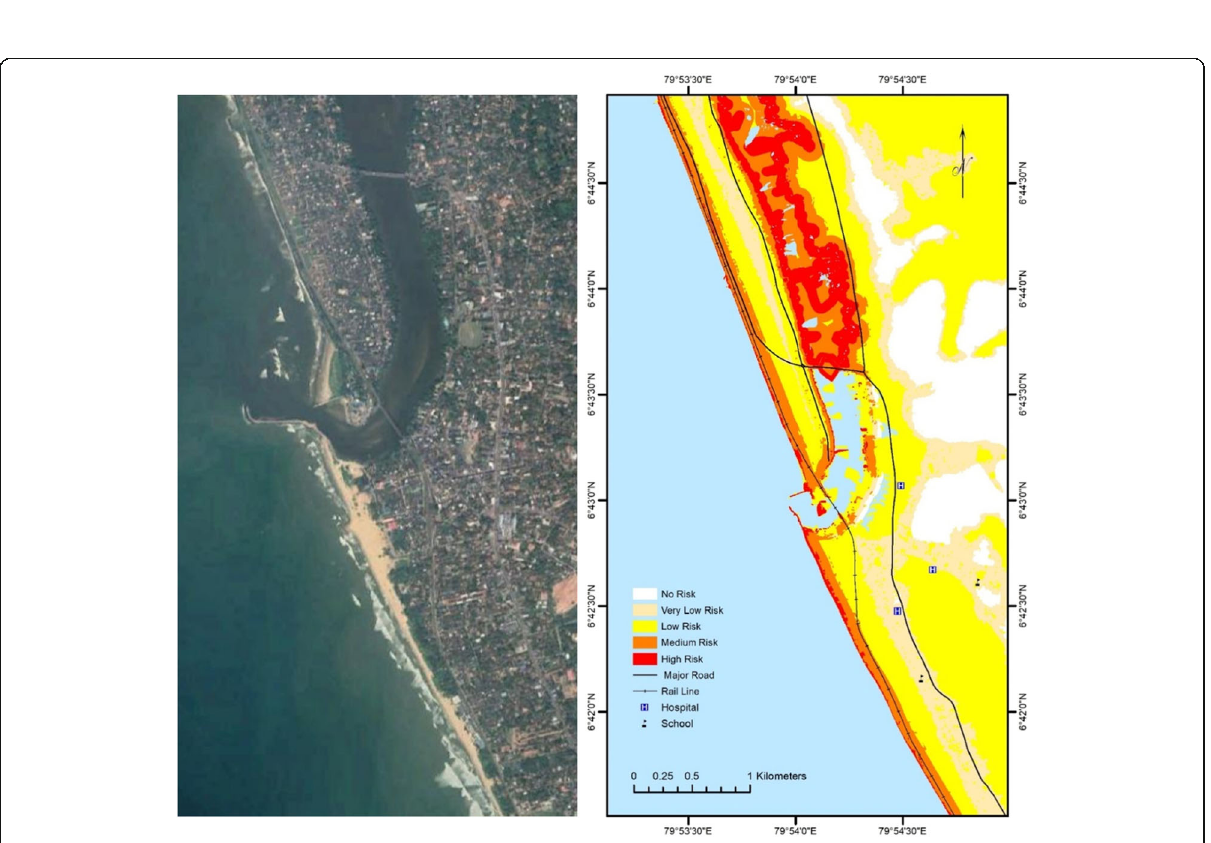
Fig. 4 ( a ) Satellite image of Panadura, and ( b ) risk assessment map of the